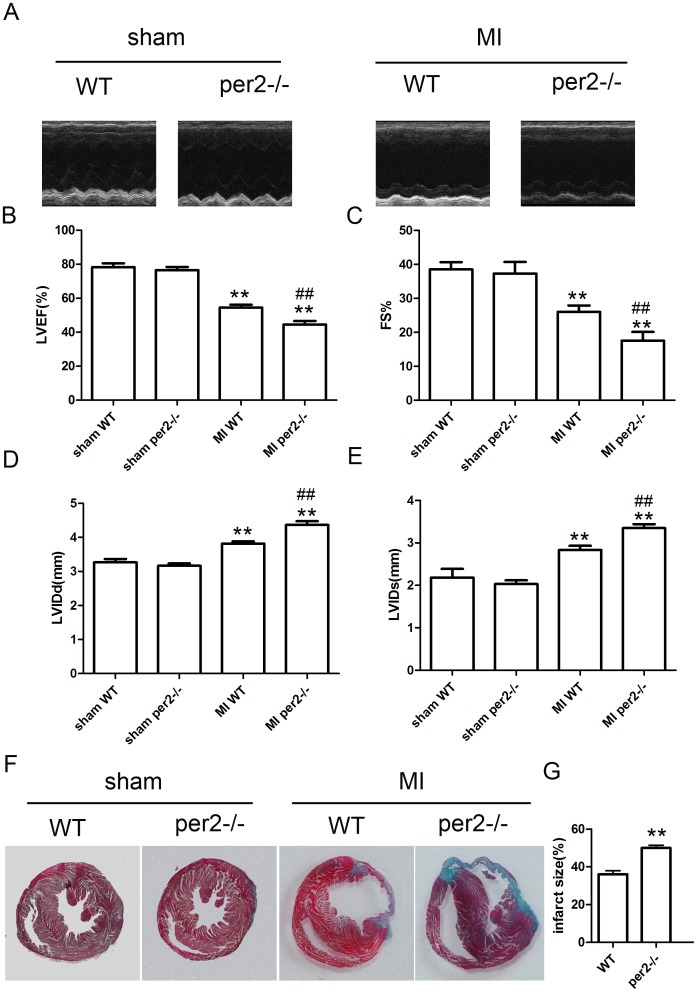
Left ventricular remodeling and infarct size in wild-type (WT) and Period 2-deficient (per2−/−) mice after myocardial infarction (MI).(A) Representative M-mode images of papillary muscles. (B–E) Systolic dysfunction 4 weeks after acute MI in mice (** p<0.01 vs sham-operated, ## p<0.01 vs MI WT). (F) Representative Masson's trichrome staining at 28 days after MI. (G) Quantitative analysis of infarct area (** p<0.01 vs WT). LVEF, left-ventricular ejection fracton; FS, fractional shortening; LVIDd, LV internal dimension diastolic; LVIDs, LV internal dimension systolic.